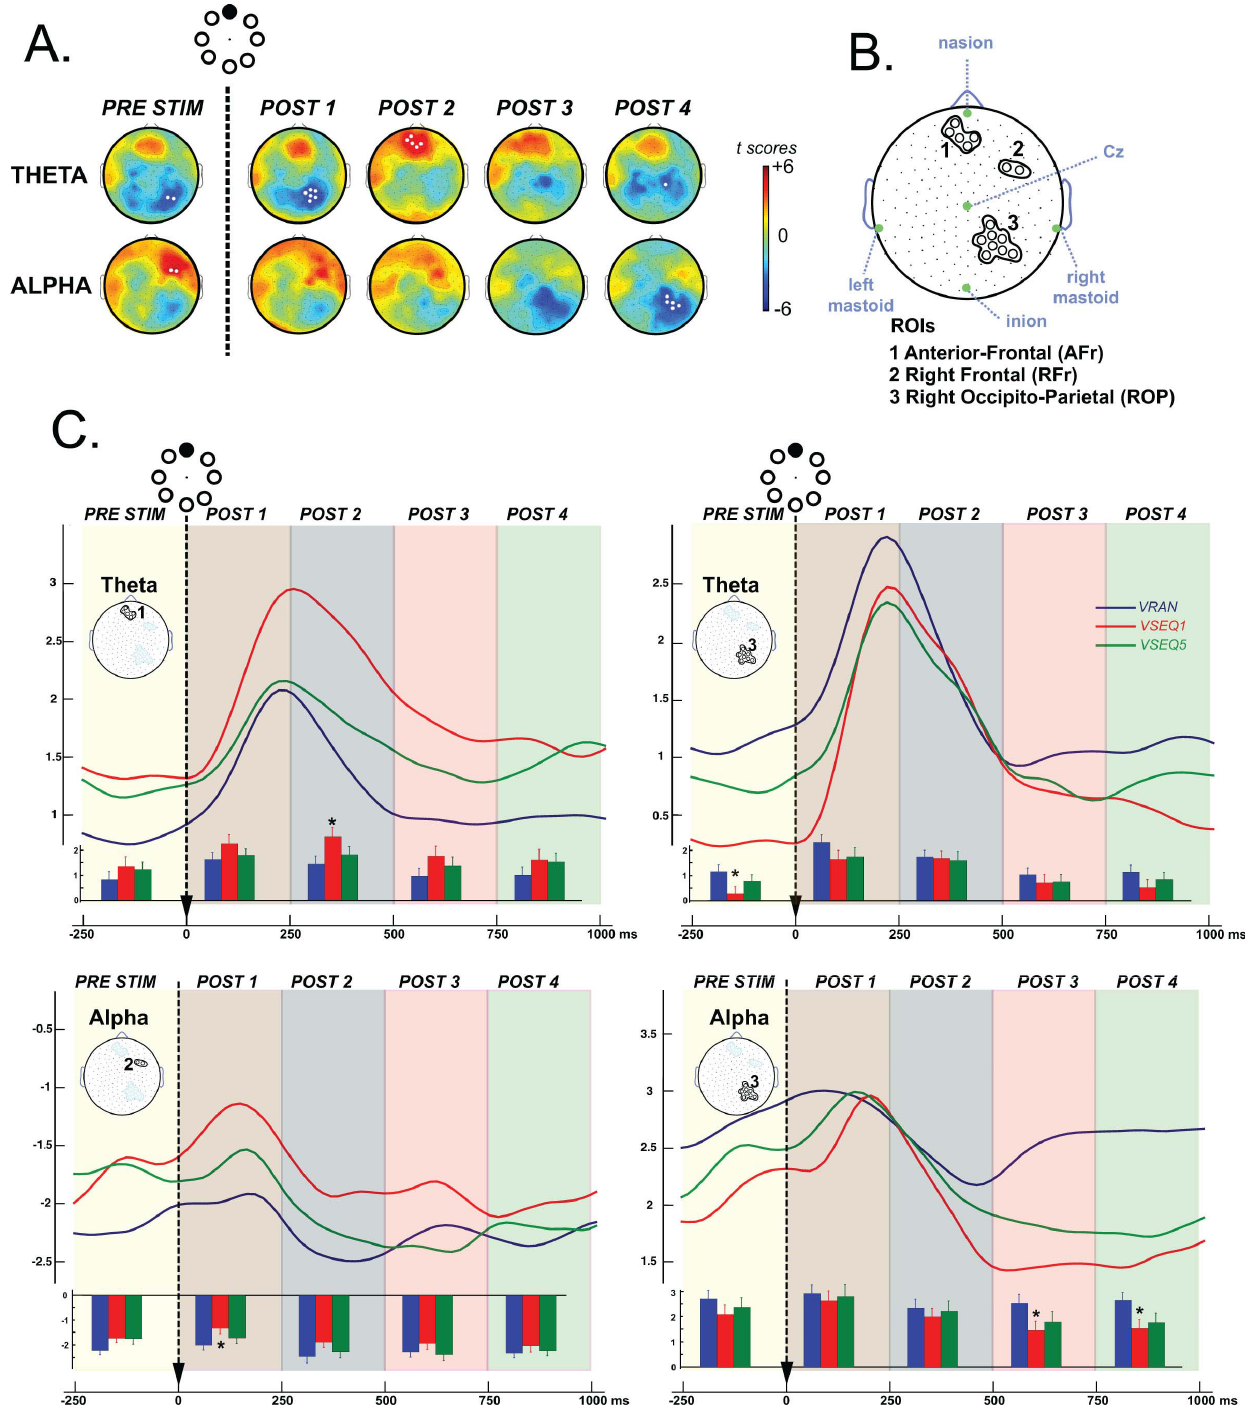
Figure 3. Spectral power analysis. A. Statistical nonparametric mapping analysis of the difference between VRAN and the average of the five blocks of VSEQ in five 250-ms temporal windows for theta and alpha frequency bands. The white circles indicate electrodes with significant power differences. B. Identification of the three ROIs based on significant power differences in A. C. Time course of the average normalized spectral power VRAN (blue), VSEQ1 (red) and VSEQ5 (green) for the three ROIs in B. in theta (upper row) and alpha (lower row) frequency bands. Bars at the bottom of each graph represent the mean power ( 6 SE) for the corresponding time interval, with asterisks indicating significant (p , 0.05) contrasts. doi:10.1371/journal.pone.0065882.g003 Importantly, no significant changes were observed in the control significant electrodes, see Figure 5) with the significant EEG experiment ( control RS2 vs control RS1). We then correlated the changes observed during learning in ROP area for both theta and changes in the resting state EEG (RS2-RS1, averages over the alpha ranges. The changes in the resting state EEG were positively